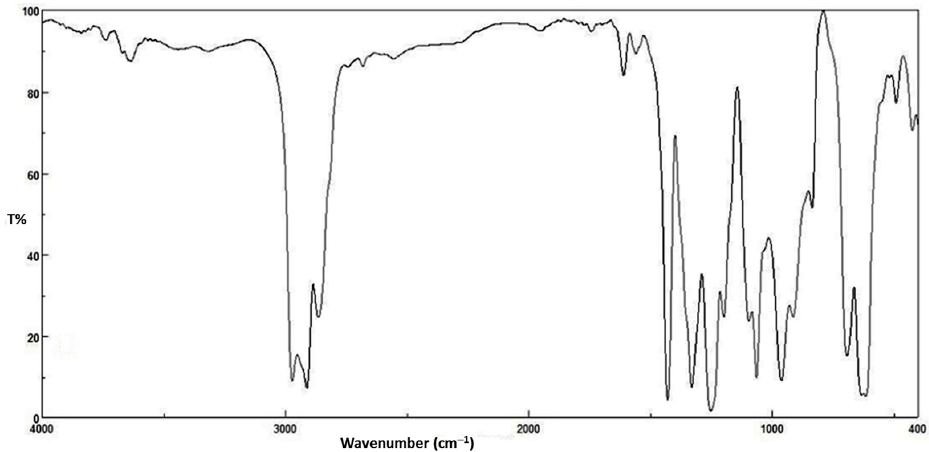
Figure 2. FTIR spectrum of PVC film containing Bu 2 SnL 2 complex before irradiation.